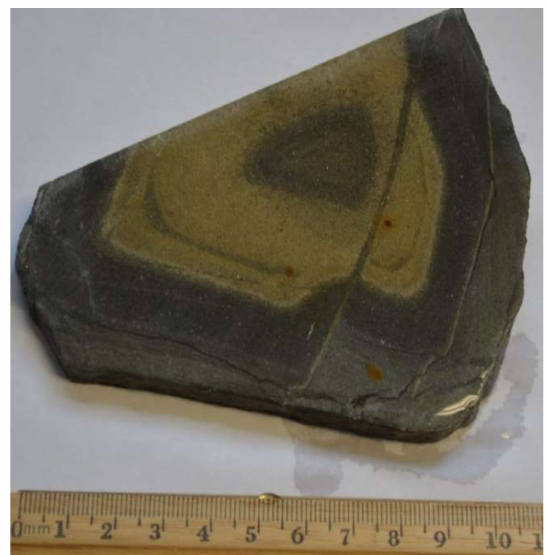
Figure 10. Photograph displaying sericitic alteration associated with gold mineralization in sample LG-85-3. This sample was taken from underground at the Lake George mine from the gold zone in the 1150 level on the west